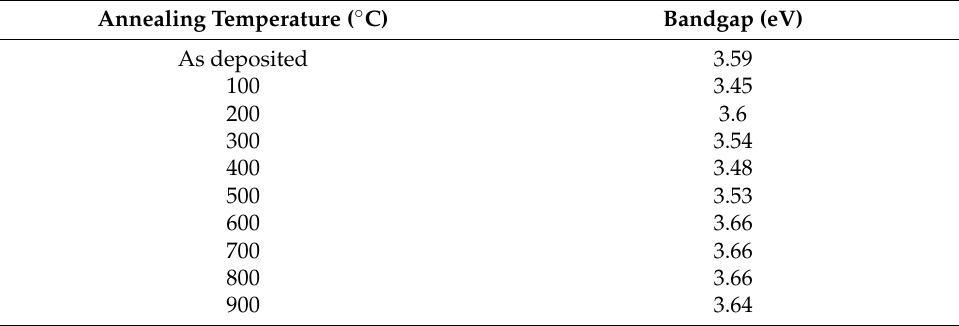
Table 1. Optical bandgap values obtained for Cu 2 In 2 O 5 thin